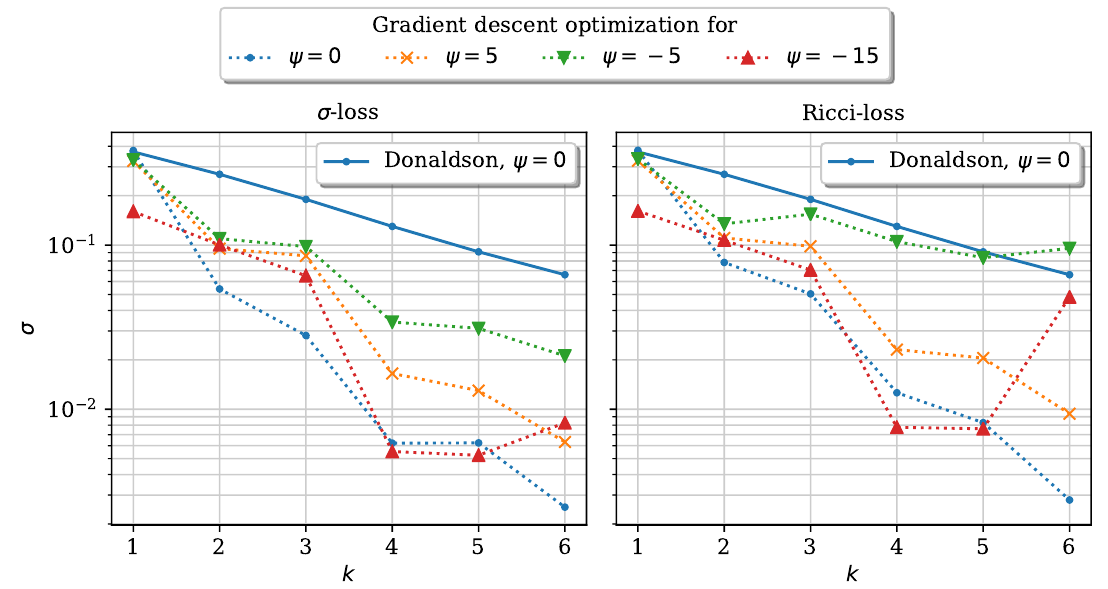
Figure 11 . σ -accuracies achieved by an optimization of the H matrix using gradient descent with respect to the Monge-Ampère loss on the left, and the Ricci loss of equation (C.1) on the